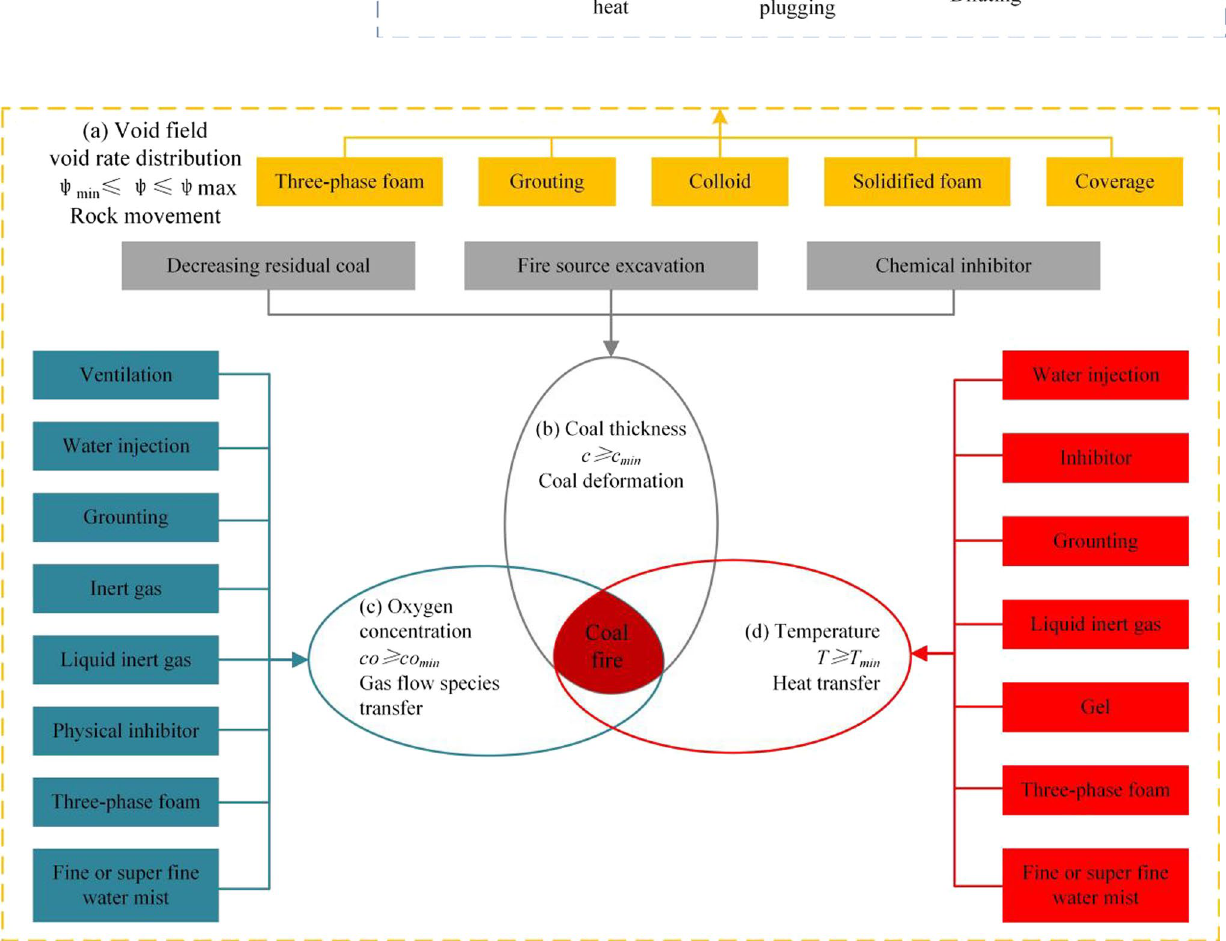
Fig. 9 Diagram of the multiphysics coupling mechanism and fire prevention mechanism of underground coal fires (Wang et al.